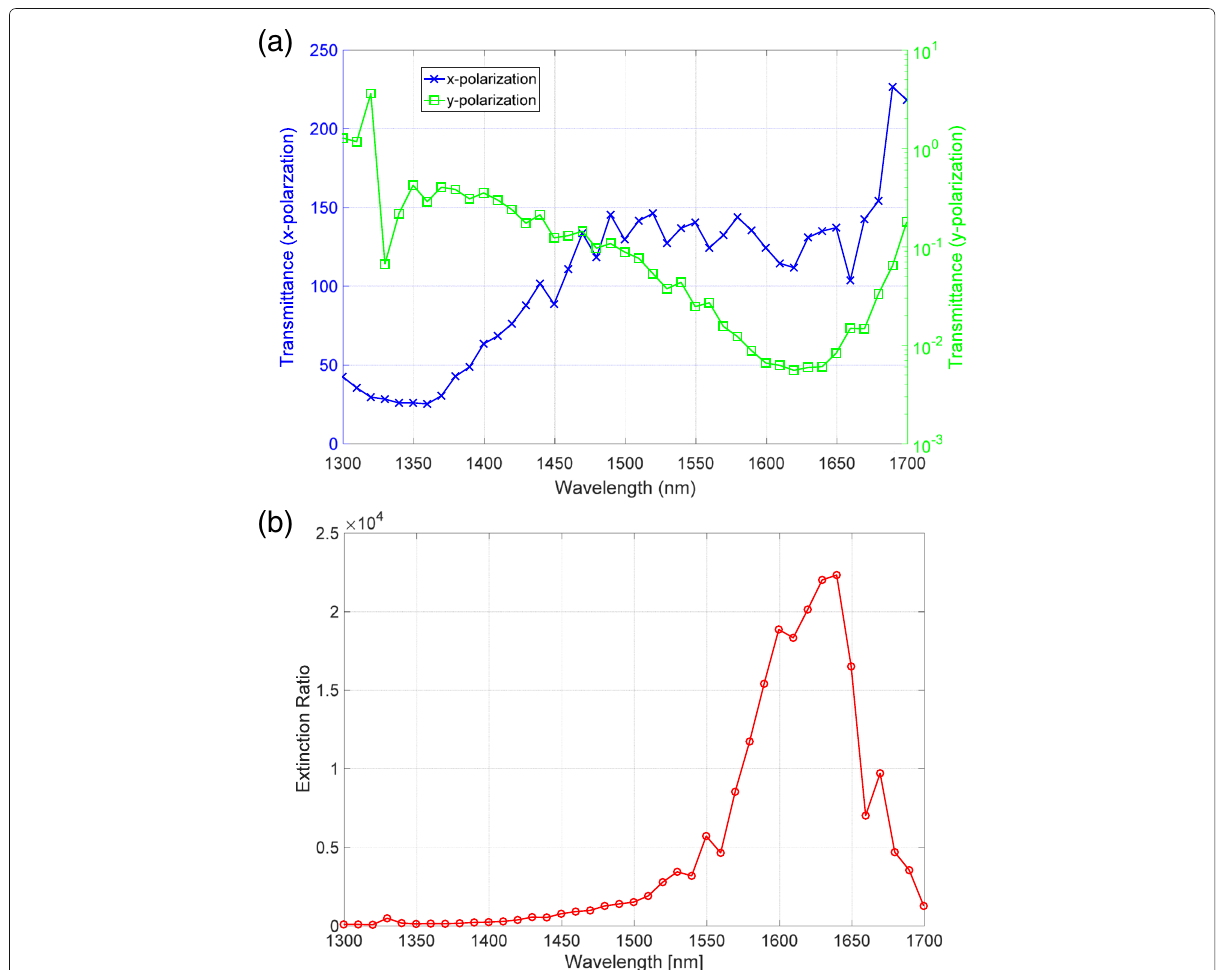
Fig. 5 a Transmittance spectra for the x (blue) and y (green) polarizations measured by the setup shown in Fig. 1. b The extinction ratio spectrum of the metasurface polarizer